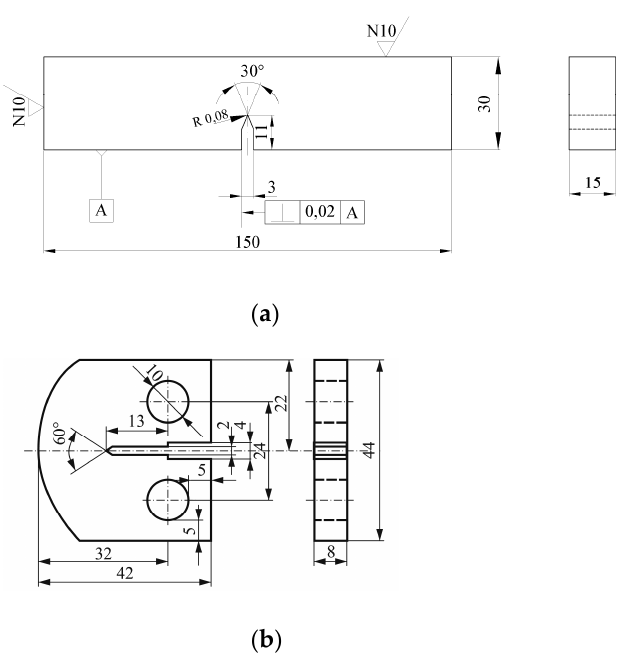
Figure 4. Specimens for K Ic testing. ( a ) SENB, ( b ) CT.